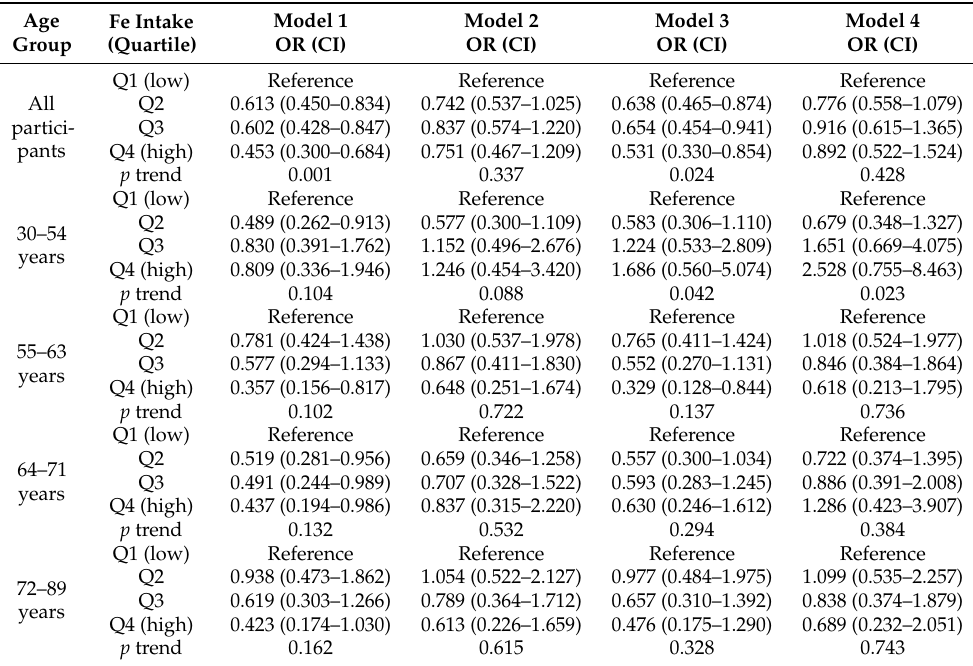
Table 3. Binary regression analysis of quartiles of Fe intake and obesity by quartiles of age group adjusted by food